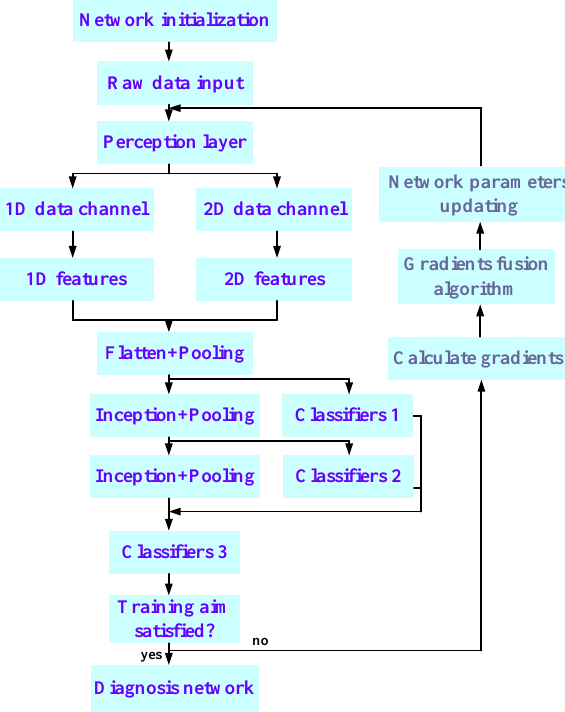
Figure 4. Algorithm flow chart of AF-CDN.